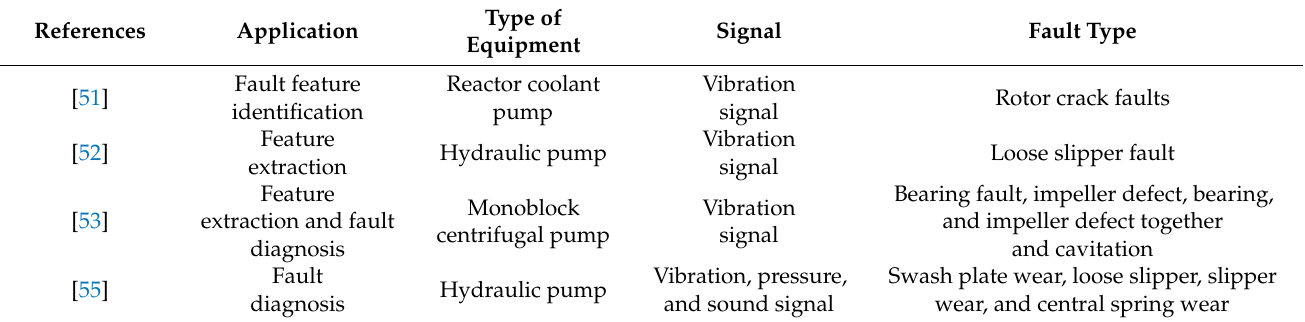
Table 5. Pump condition monitoring using wavelet